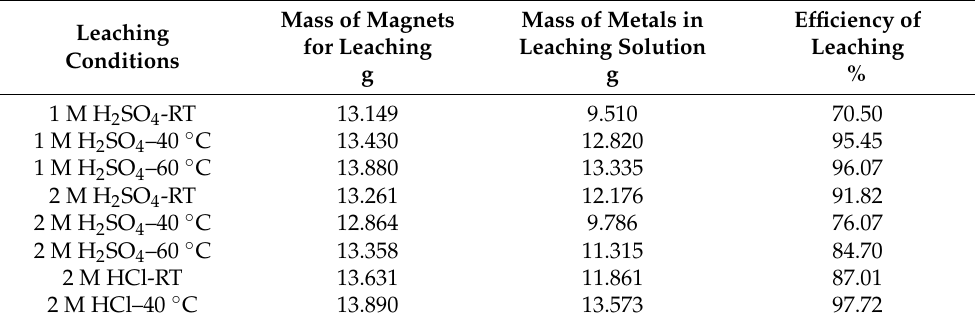
Table 7. Calculated total leaching efficiencies based on the mass of magnets before leaching and the mass of metals in the leaching